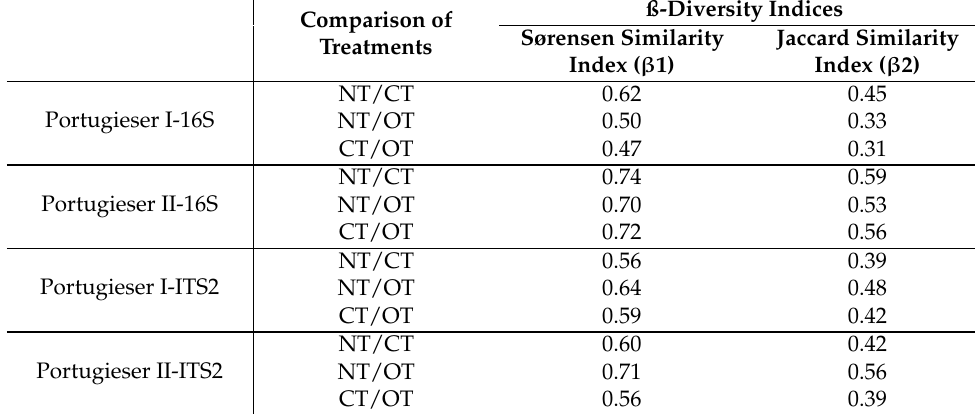
Table 2. ß-diversity indices obtained from 16S and ITS sequencing of carpoplane microbiota. Samples derived from Portugieser berries 1 day (Portugieser I) or 2 weeks (Portugieser II) after the last agrochemical treatment. Non-treated (NT), conventionally treated (CT) and ozonide-treated (OT) samples were compared. ß-Diversity Indices Comparison of